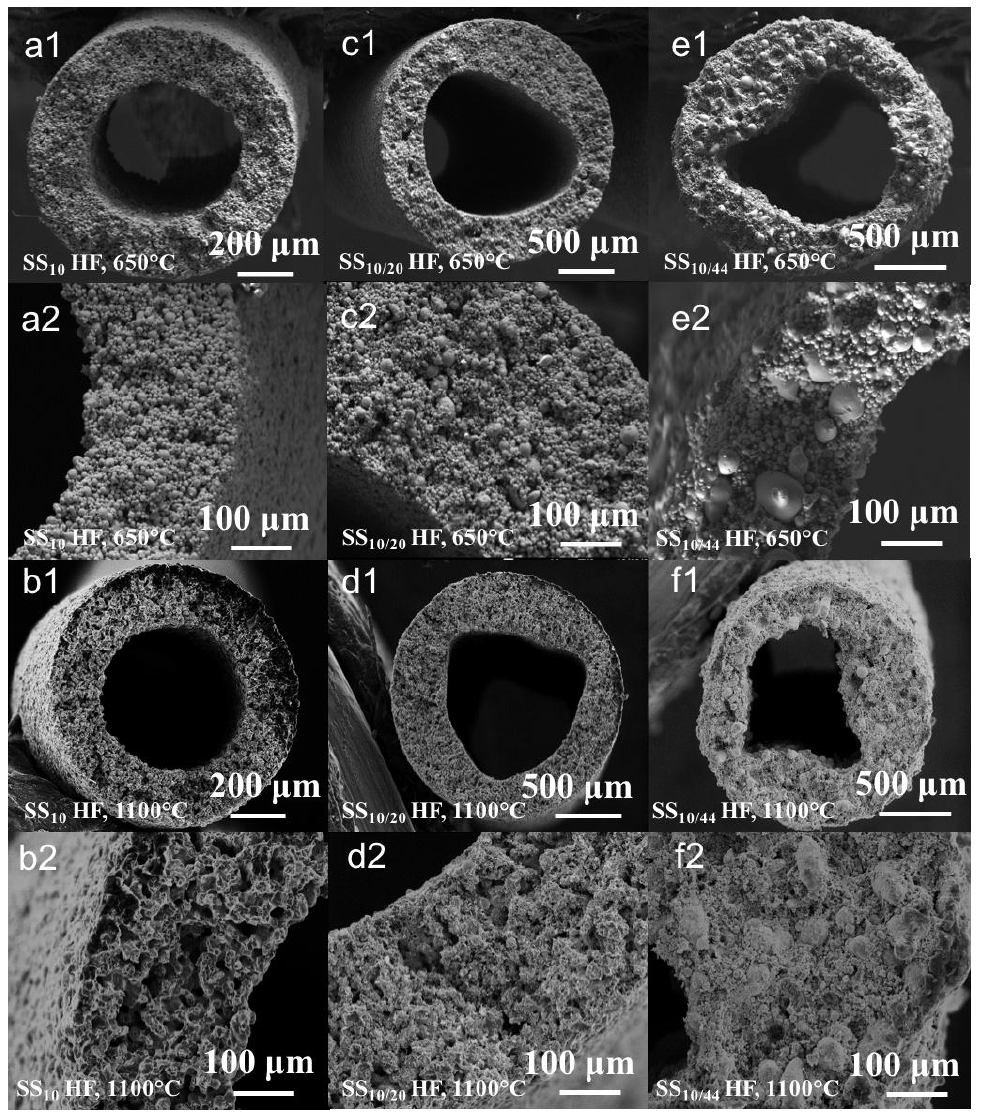
Figure 5. Cross-sectional SEM images of the sintered SS 10 HFs for 90 min at 650 °C ( a1 , a2 ) and 1100 °C ( b1 , b2 ); sintered SS 10/20 . HFs for 90 min at 650 °C ( c1 , c2 ) and 1100 °C ( d1 , d2 ); sintered SS 10/44 . HFs for 90 min at 650 °C ( e1 , e2 ) and 1100 °C ( f1 , f2 ).